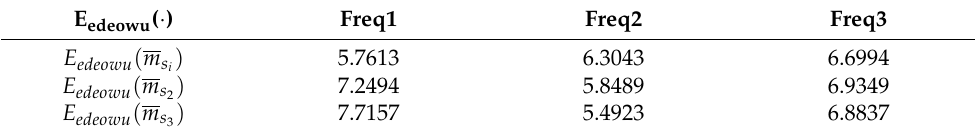
Table 8. Uncertain degree of BPAs.